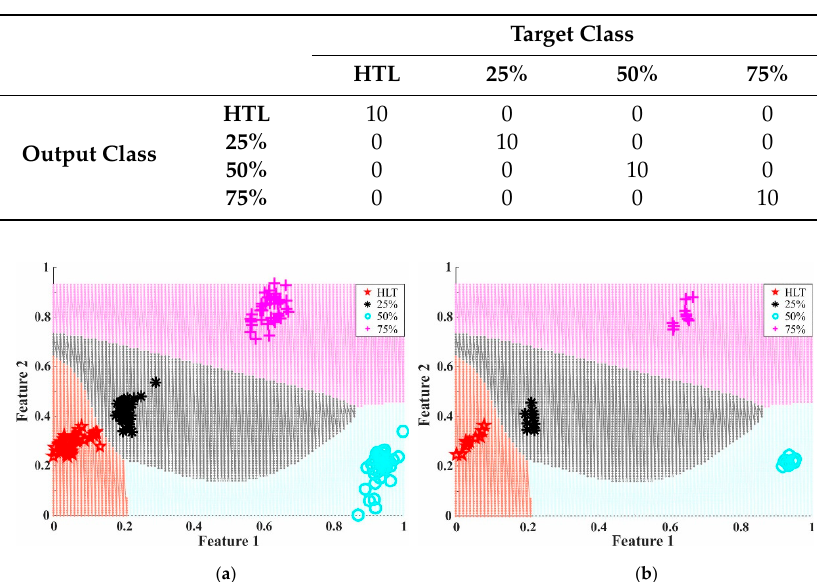
Table 3. Confusion matrix for the training of the ANN classifier with infrared imaging.